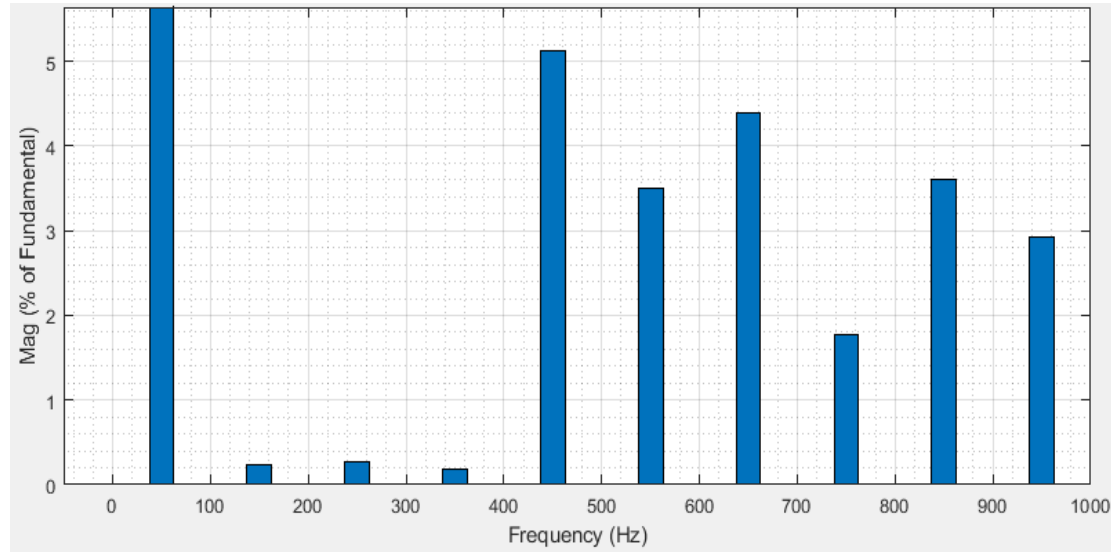
Figure 8. FFT analysis for a nine-level inverter via DA. Table 3. Percentage harmonics (w.r.t. fundamental) for nine-level CHB inverter.